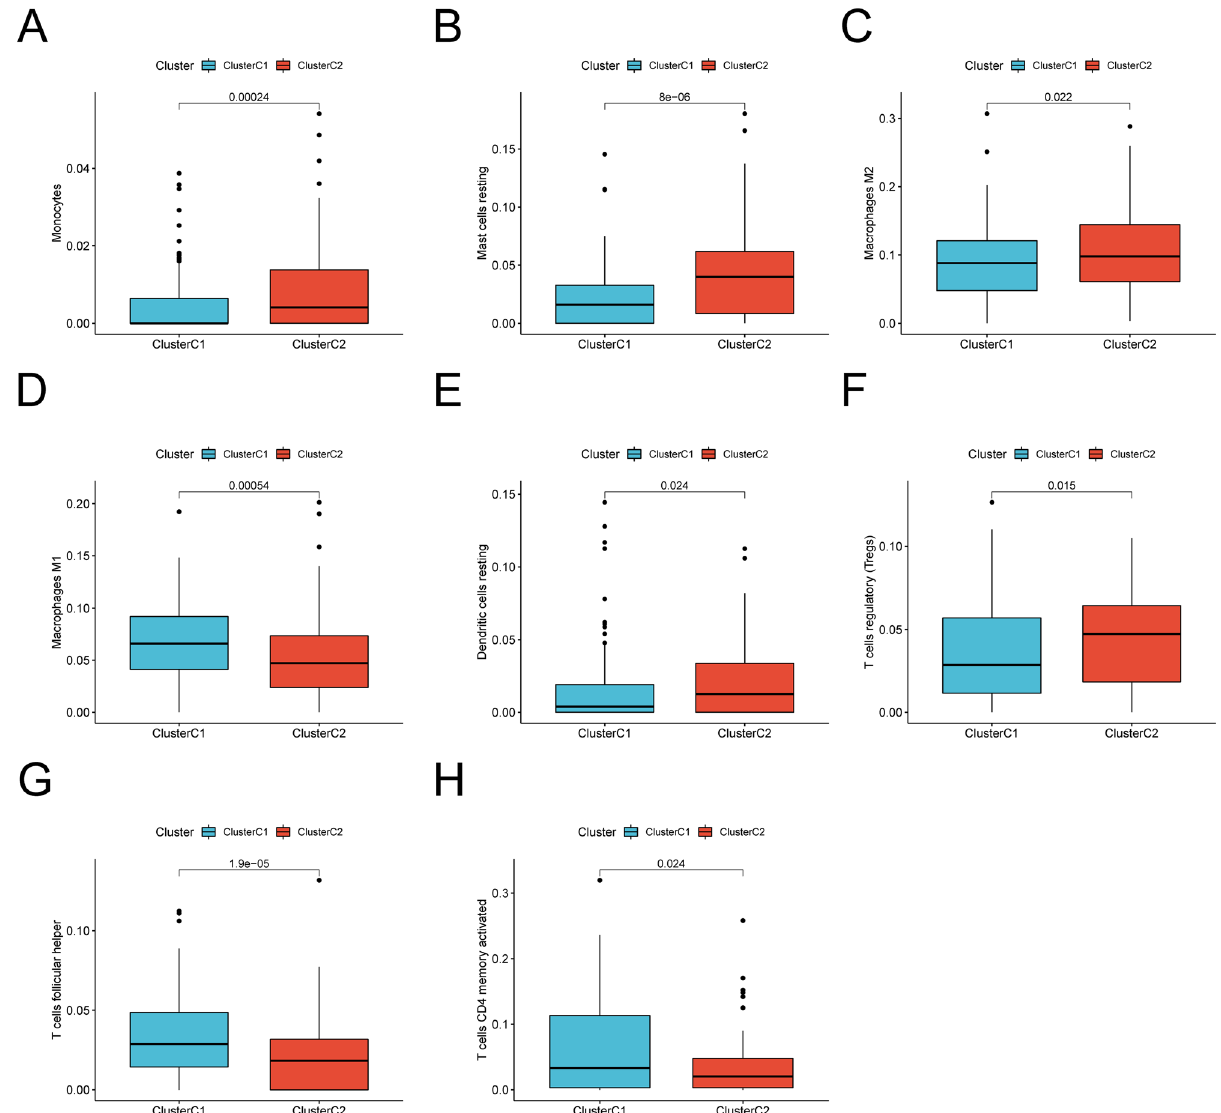
Figure 3. TME immune cell infiltration levels between two molecular subtypes. The abundance of Monocytes ( A ), resting Mast cells ( B ), M2 macrophages ( C ), M1 macrophages ( D ), resting Dendritic cells ( E ), T cells regulatory (Tregs) ( F ), T cells follicular helper ( G ) and activated T cells CD4 memory ( H ) between the two subtypes (all p < 0.05). Blue represents cluster C1, red represents cluster C2. The median value is represented as the thick line, and the interquartile range is represented as the box bottom and top. Scattered dots represent